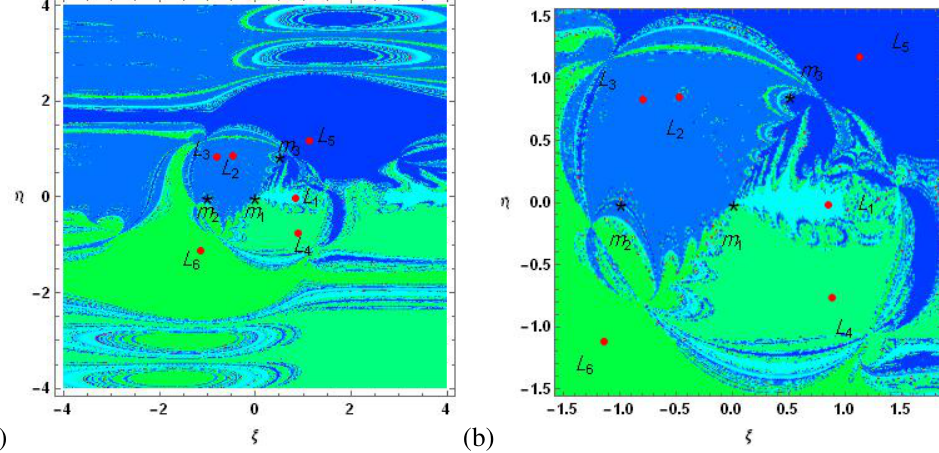
Fig. 7 (a): The basin of attraction for the variable mass case. (b): Zoomed image of (a) near the lagrangian configuration. points L 2 , L 3 , L 4 , L 5 , L 6 extend to infinity. While in the rest three cases (Fig. 8, Fig. 9, Fig. 10), L 1 represents cyan color region, L 2 , L 3 represent light blue, L 5 represents blue color region and L 4 , L 6 , L 7 , L 8 represent light green color regions. The basins of attraction corresponding to the all lagrangian points L 2 , L 3 , L 4 , L 5 , L 6 , L 7 , L 8 extend to infinity except L 1 which covers finite area. In this way a complete view of the basin structures created by the attractors. We can observe in detail from the zoomed part of all the figures in Fig. 6(b), Fig. 7(b), Fig. 8(b), Fig. 9(b), Fig. 10(b). The black points and black stars denote the location of the lagrangian points and the primaries